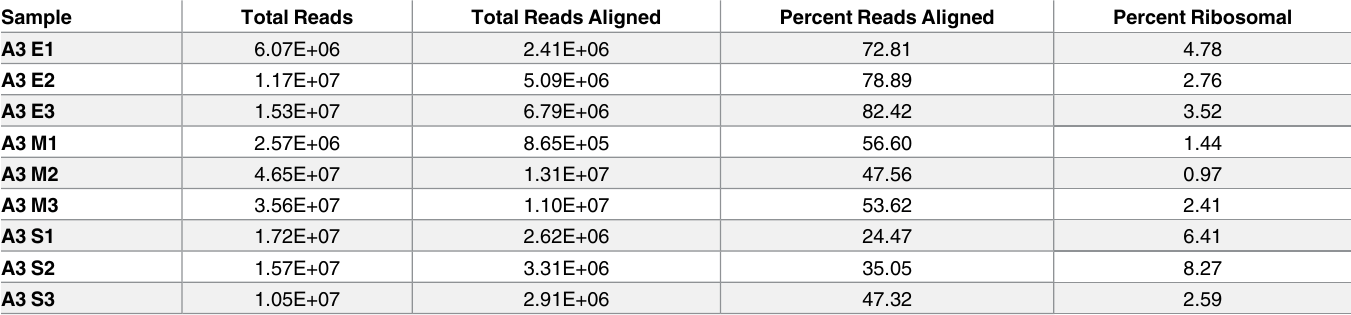
Table 1. Sequencing metrics. Sequencing metrics for each sample includingsample name, total reads, total reads alignedto the B31-MI genome, per- centage of reads alignedto the B31-MI genome, and the percentage of reads mapping to ribosomalRNA loci.